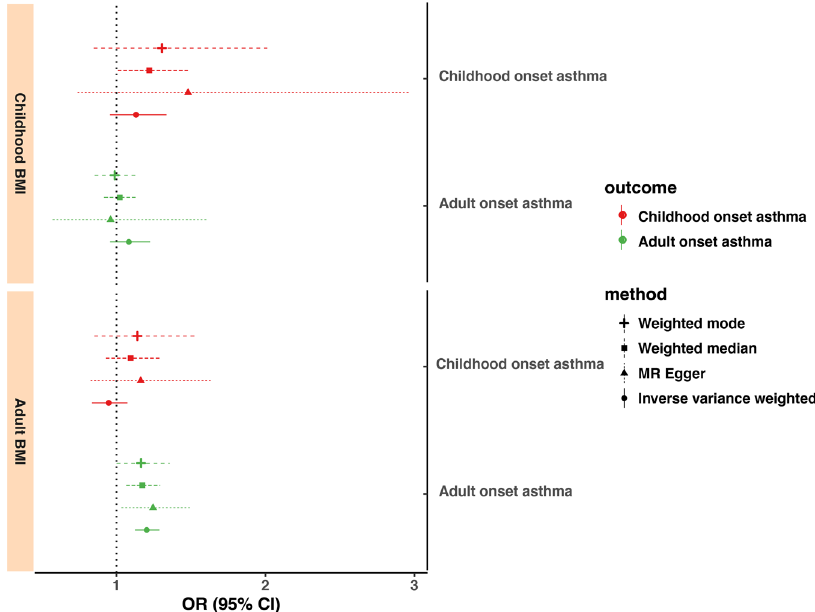
Fig. 3 Mendelian randomization estimates of the association between body mass index and childhood- and adult-onset asthma. The x -axis is the odds ratio (OR) of the effects for per standard deviation increase in BMI (exposure) on asthma (outcome) in children and adults. The vertical dashed line is the reference at OR = 1. Different Mendelian randomization methods are displayed in different line